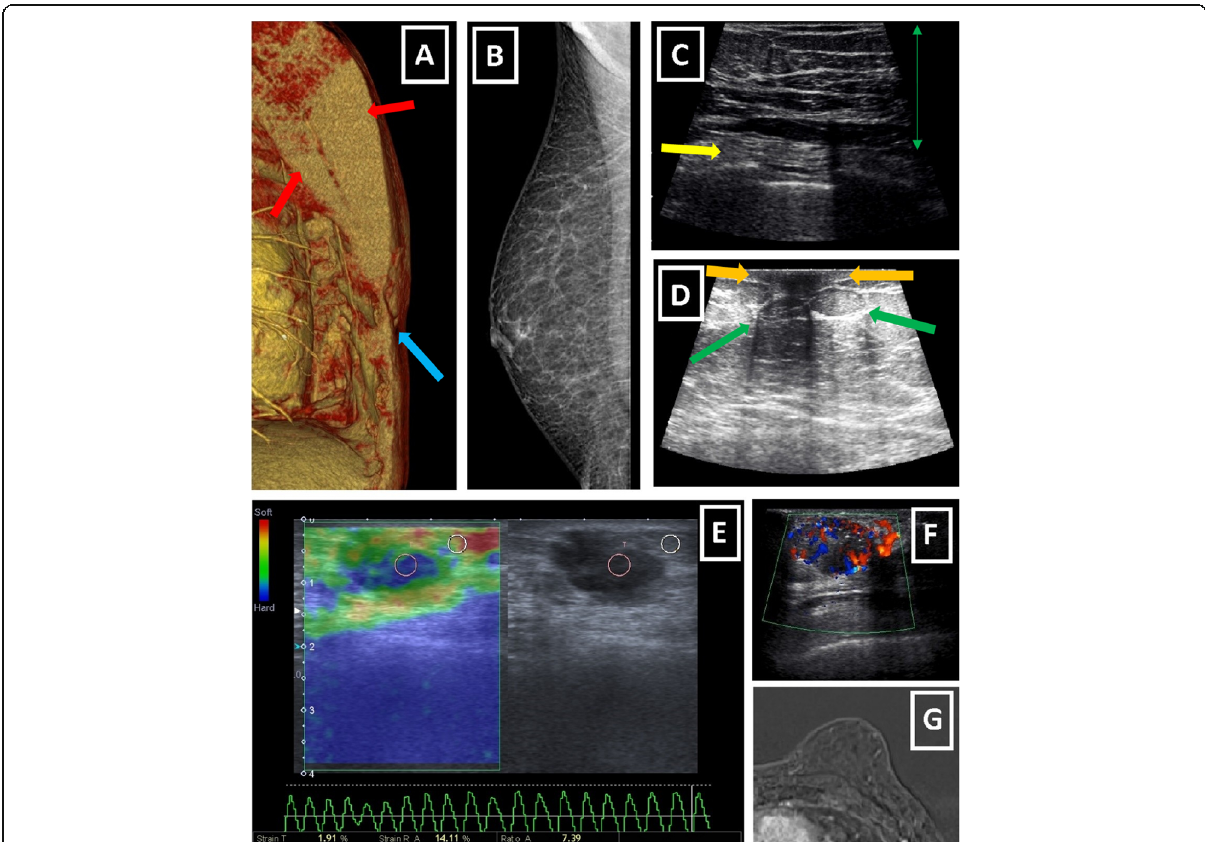
Fig. 3 Imaging modalities used for male breast diseases. a Oblique sagittal VRT reformat of a CT scan obtained for an irrelevant purpose shows hypertrophic pectoralis major and minor muscles (red arrows) and retroareolar scarce fat tissue (blue arrow). Both can cause technical and diagnostic difficulties for mammography. Although it can show masses incidentally, CT is not a routine imaging modality for male breast. b MLO mammogram of right male breast shows rudimentary fibroglandular tissue replaced with increased amount of radiolucent adipose tissue. c , d US images of male breast. Green arrows show subcutaneous fat tissue characterized by isoechoic fat lobules. Yellow arrow ( c ) represents intercostal muscles and orange arrow ( d ) corresponds to small nipple-areola complex with no associated fibroglandular tissue. e Sonoelastographic evaluation of ill-defined hypoechoic male breast mass reveals elevated tissue stiffness with considerably increased strain ratio of 7.39 and suggests malignity. Pathologic examination confirms the diagnosis of IDC. f Color mode of Doppler US shows markedly increased peripheral and internal vascularity of irregular hypoechoic male breast mass which is diagnosed as IDC later. g Subtraction image of dynamic breast MRI of a male patient with known pseudogynecomastia shows enlarged left male breast without apparent enhancing